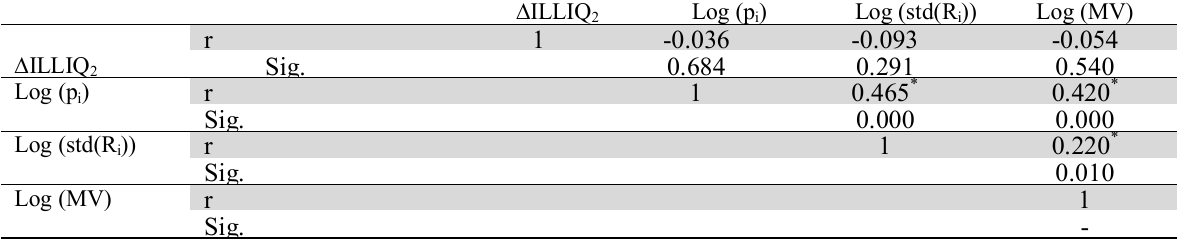
The summary of Pearson correlation ratios for variables associated with the second hypothesis